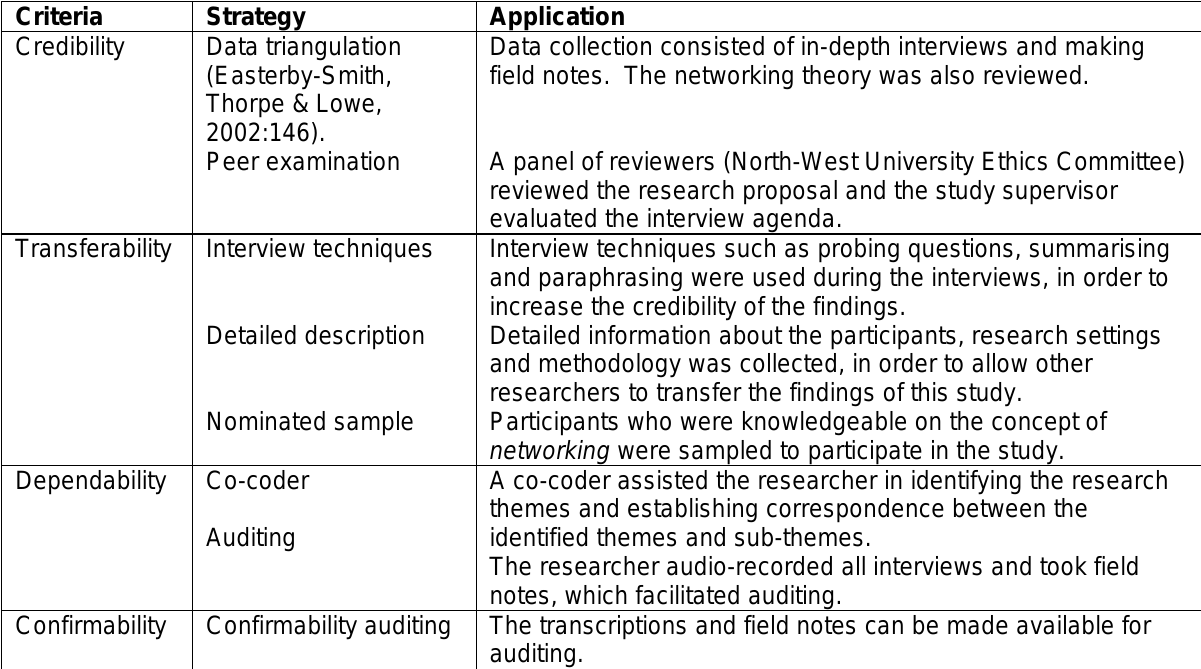
Table 1:Strategies applied to ensure the trustworthiness of the findings